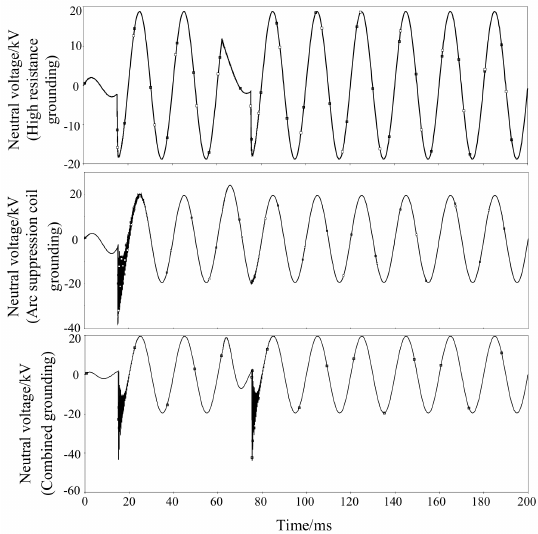
Figure 10. Neutral voltage drift waveform of reignition